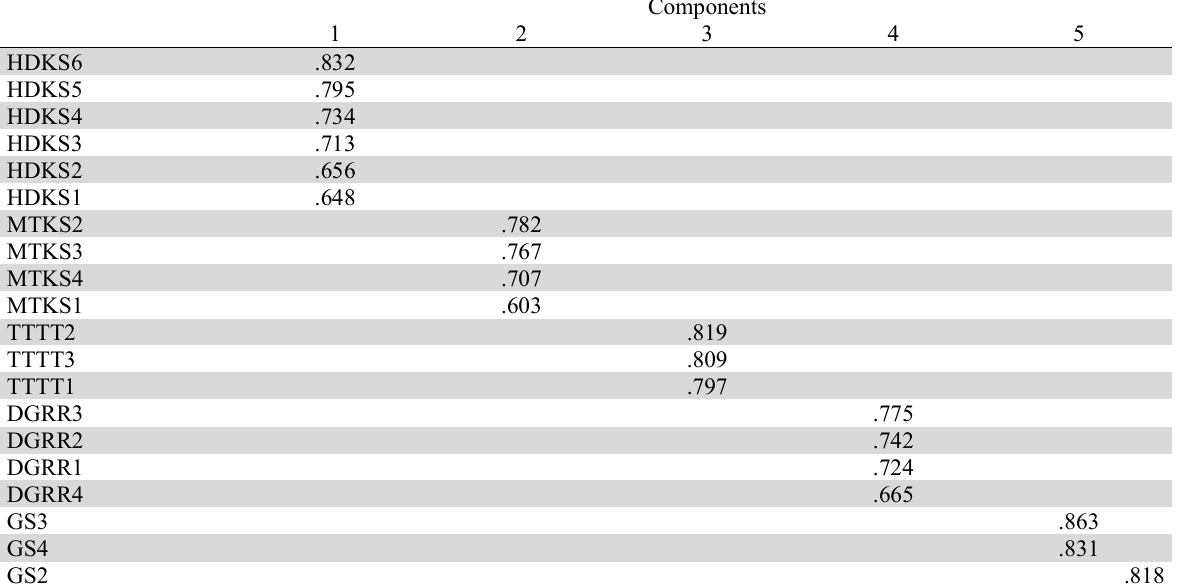
The results of EFA test